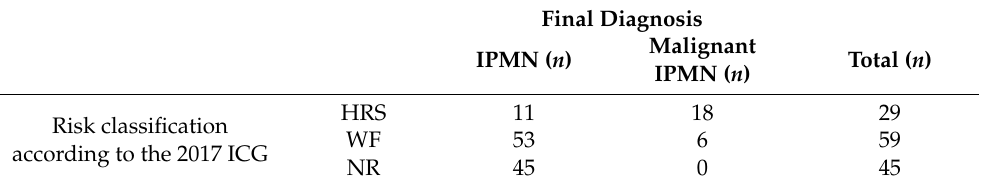
Table 3. Rate of malignant IPMN for each imaging finding. Factors (%) n Obstructive jaundice 100% 1/1 Enhancing mural nodule ≥ 5 mm 69.6% 16/23 Main pancreatic duct ≥ 10 mm 61.5% 8/13 Past history of pancreatitis N.A. 0/0 Cyst ≥ 3 cm 29.2% 14/48 Thickened/enhancing cyst walls 25.0% 5/20 Main pancreatic duct size of 5–9 mm 37.5% 12/32 66.7% 2/3